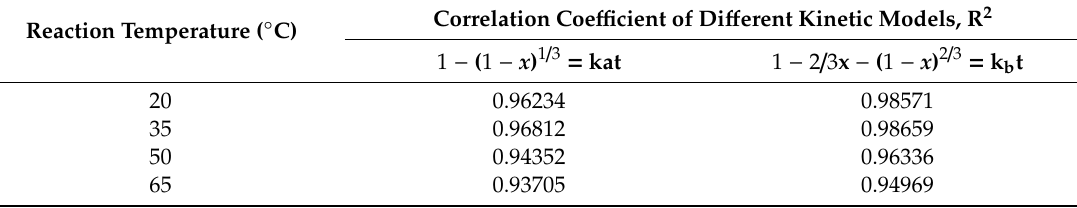
Table 2. Correlation coefficient (R 2 ) values for the different reaction temperatures and kinetic data. Reaction Temperature (°C)